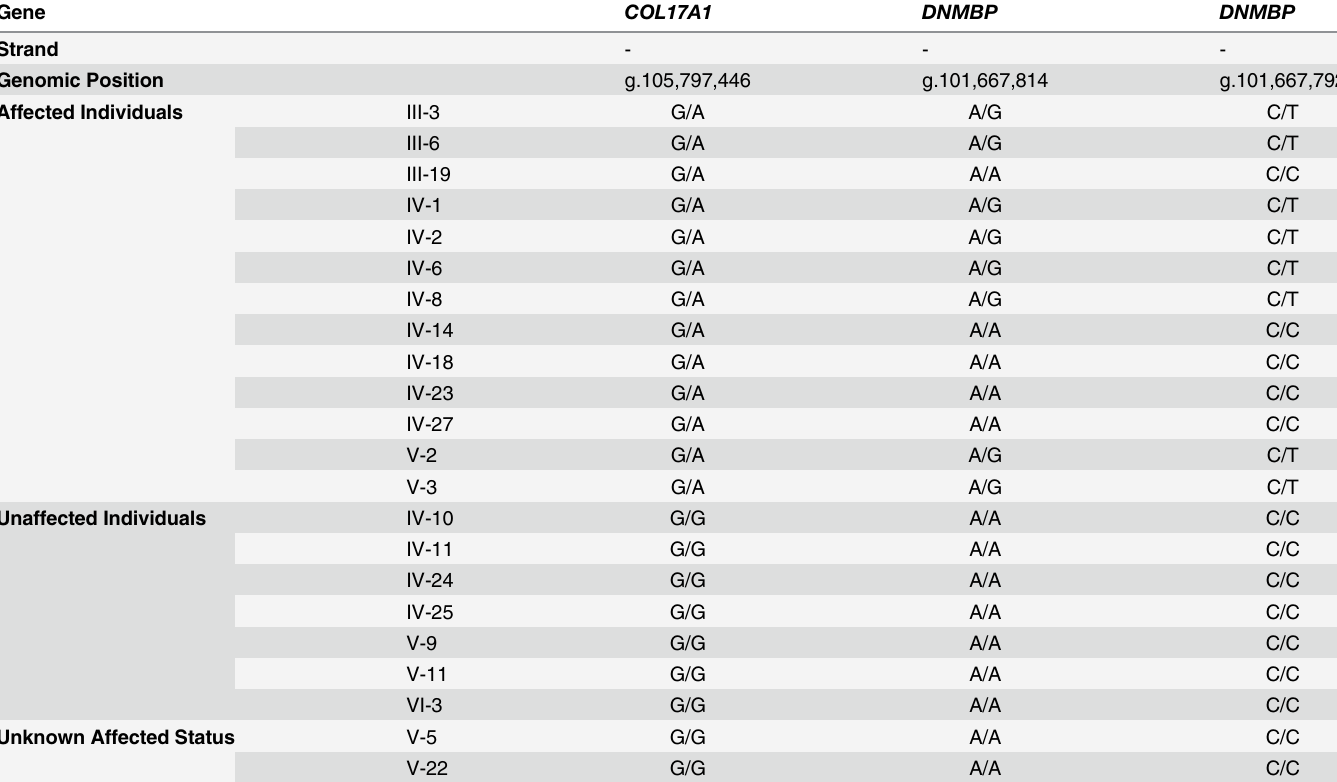
Table 2. Sanger sequencing results of filtered candidate variants for the corneal dystrophy linked to chromosome 10q23-q24. Gene COL17A1 DNMBP DNMBP Strand - - - Genomic Position Affected